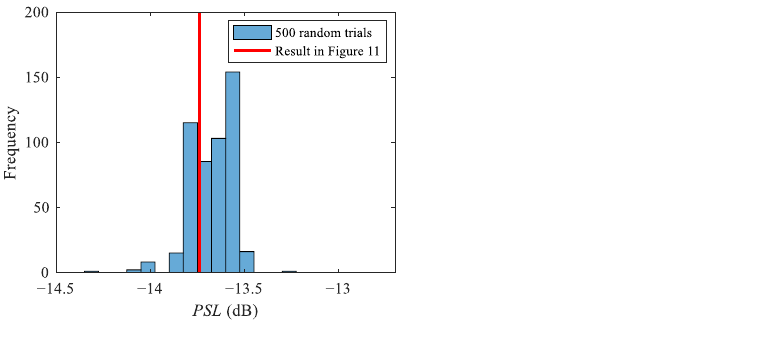
Figure 15. Histogram of the PSL values obtained over 500 random trials when the parameters are M = 4, N = 64, and K = 4.